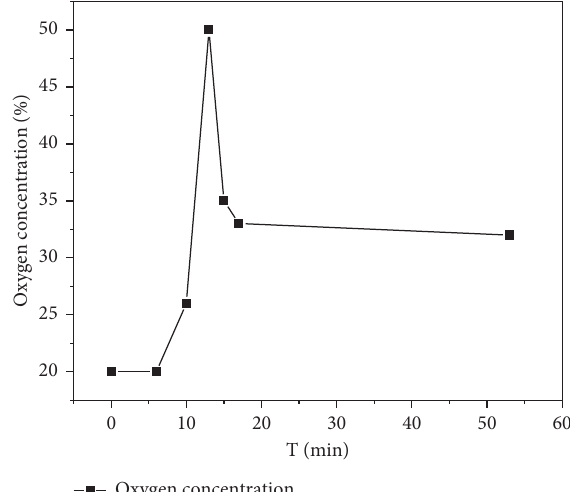
Figure 9: Oxygen candle O 2 concentration curve of test